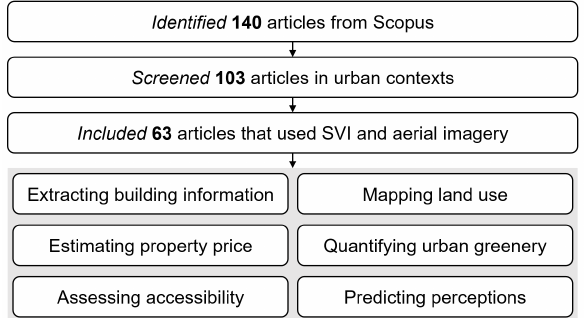
Figure 2. The result of our literature review yielded 63 papers that are of relevance to this paper and they can be categorised into six applications. resolution aerial imagery achieved better model